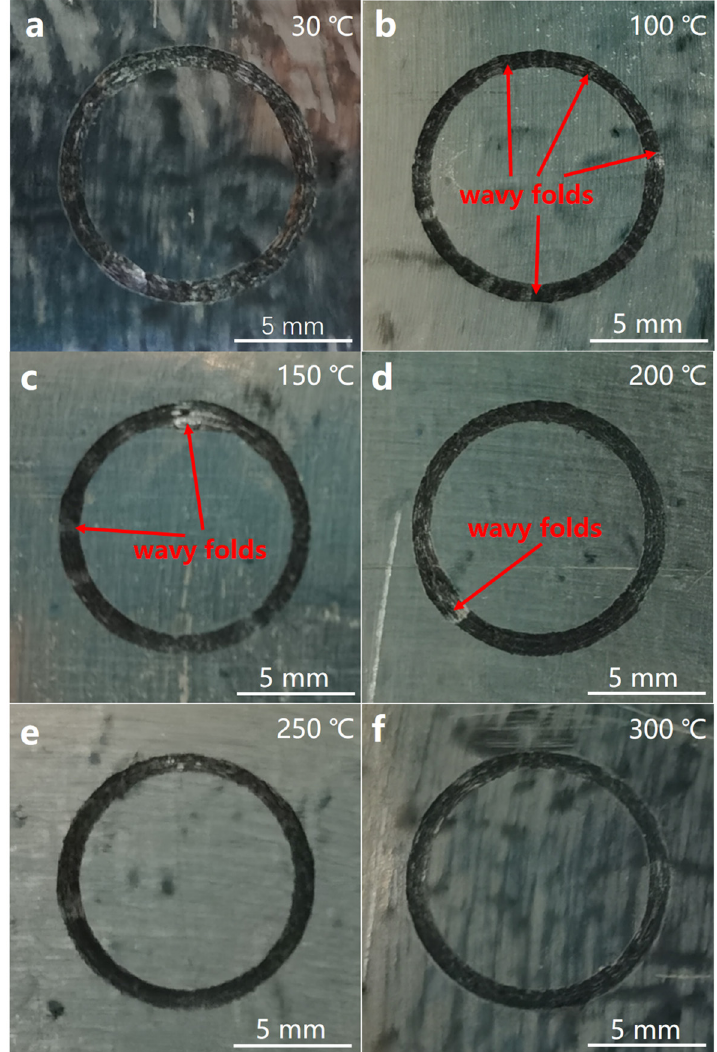
Figure 3. ( a – f ) Macrostructures of the wear surfaces of 30 °C, 100 °C, 150 °C, 200 °C, 250 °C and 300 °C.